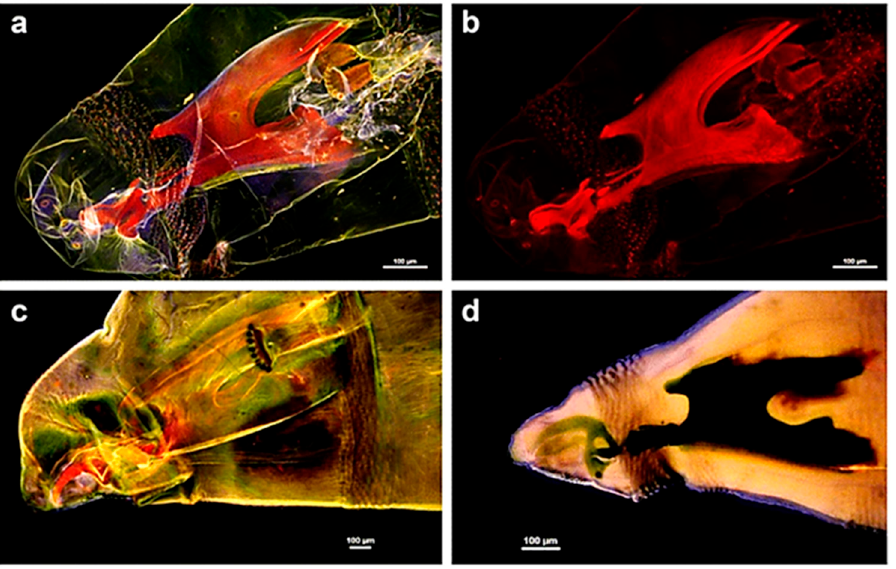
Figure 10. Cephaloskeleton of L. sericata ( a – c ) and Muscina prolapsa (Harris) ( d ) larvae. Optical sections recorded from L. sericata after clearing with KOH and Euparal embedding: ( a ) 27 optical sections from four lasers; ( b ) 27 sections from laser tuned at 640 nm; ( c ) 12 sections from four lasers. ( d ) M. prolapsa after Hoyer’s medium clearing, 11 optical sections from four lasers. The images show the importance of the proper choice of clearing procedures. Contrarily to KOH, Hoyer’s medium is unsuitable for confocal laser studies of AF since it prevents appreciation of cephaloskeleton AF, also because of emitted light absorption by soft tissues. Bars = 100 μ m. Modified from [159].